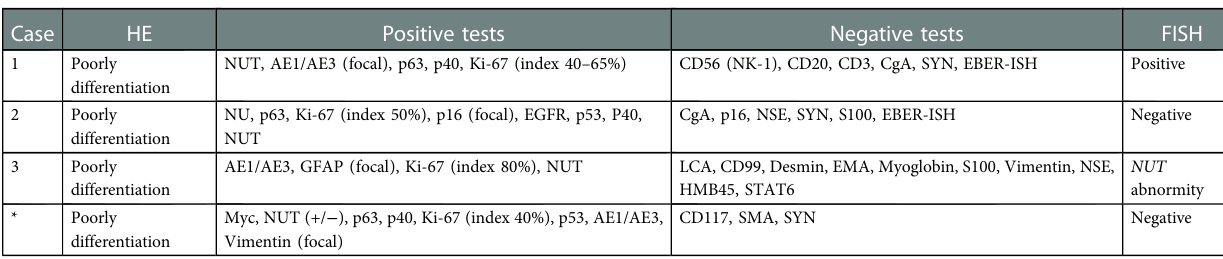
TABLE 2 Pathologic